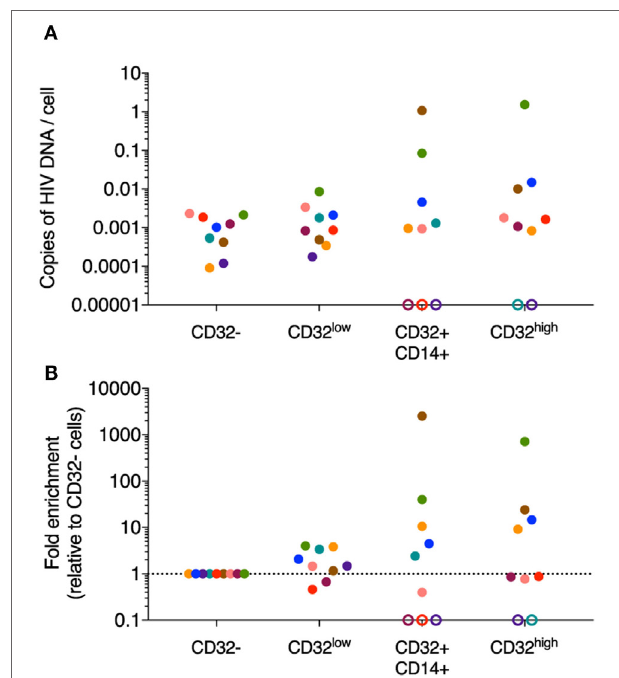
FigUre 4 | HIV DNA quantification in sorted CD32-expressing CD3 + CD4 + T cell populations. HIV DNA was quantified in sorted CD32 − , CD32 low , CD32 + CD14 + , and CD32 high CD3 + CD4 + T cell populations by qPCR ( n = 9). (a) Shows the absolute quantification of these data and (B) shows the fold change relative to the CD32 − population. Copies of HIV-1 DNA were quantified and normalized to number of input cells (as determined by albumin PCR). PCR reactions for both albumin and total HIV were performed in triplicate for the CD32 − population and in duplicate for the remaining three populations. Data shown are averages of the replicates. Data points are colored by the individual from which the population was sorted. Where no signal was detectable for a given sorted population, this is shown as an open circle on the axis. For all of these undetectable populations, we could not determine if they were in fact negative for HIV DNA as the predicted level of infection (assuming equivalent level of infection to the CD32 − fraction) was below the level of detection of our assay based on the available input cell equivalents.